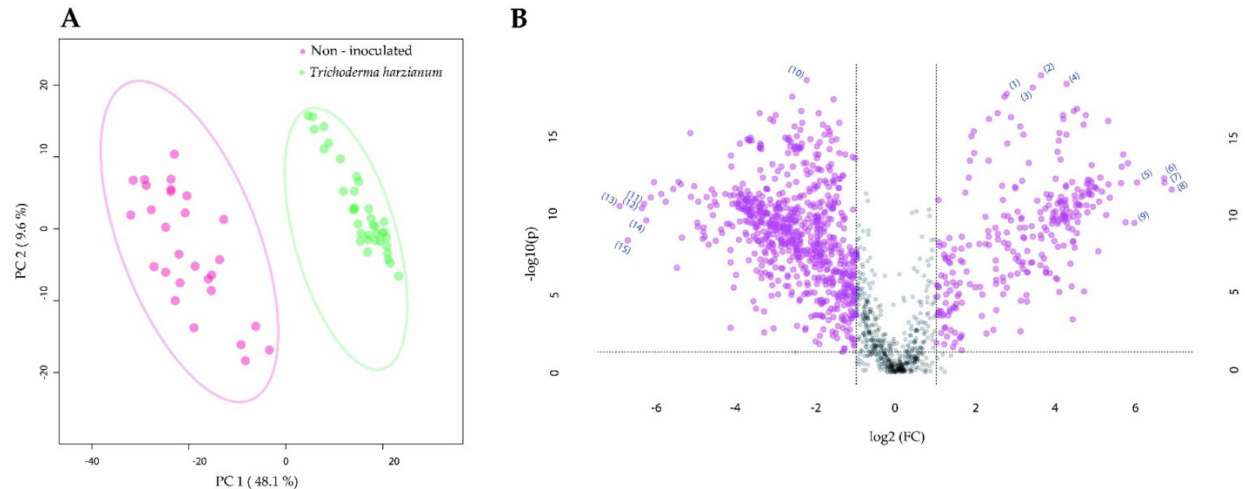
Figure 6. The impact of tomato root colonization by Trichoderma harzianum on the fat body metabolome of Manduca sexta larvae. ( A ) Two-dimensional principal component analysis (PCA) scores plot of M. sexta fat body samples. ( B ) Significant metabolomic features annotated for the M. sexta fat body samples. Manduca sexta larvae were fed for three weeks on leaves of tomato plants that were non-inoculated or root-inoculated with T. harzianum . In ( B ), the volcano plot displays fold change threshold ( x -axis) of 2 and t -test threshold ( y -axis) of 0.05. The purple circles represent features above the threshold. Both fold changes and p -values are log-transformed. The metabolomic features that showed the highest increase for the larvae reared on non-inoculated plants are found towards the right side of the volcano plot. The metabolomic features that showed the highest increase for the larvae reared on T. harzianum -inoculated plants are found towards the left side of the volcano plot. The most statistically significant metabolomic features for both treatments are found towards the top of the volcano